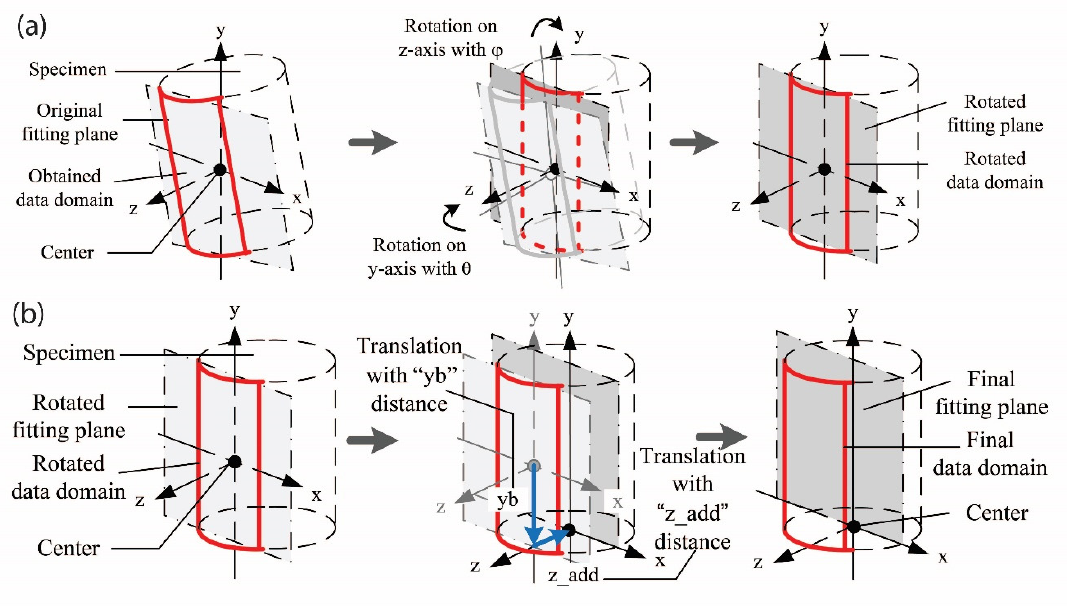
Figure 15. Schematic illustration of 3 ‐ D transformation: rotation ( a ) and translation ( b ).